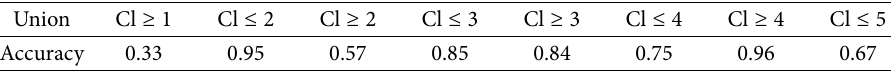
Table 5. Accuracies of